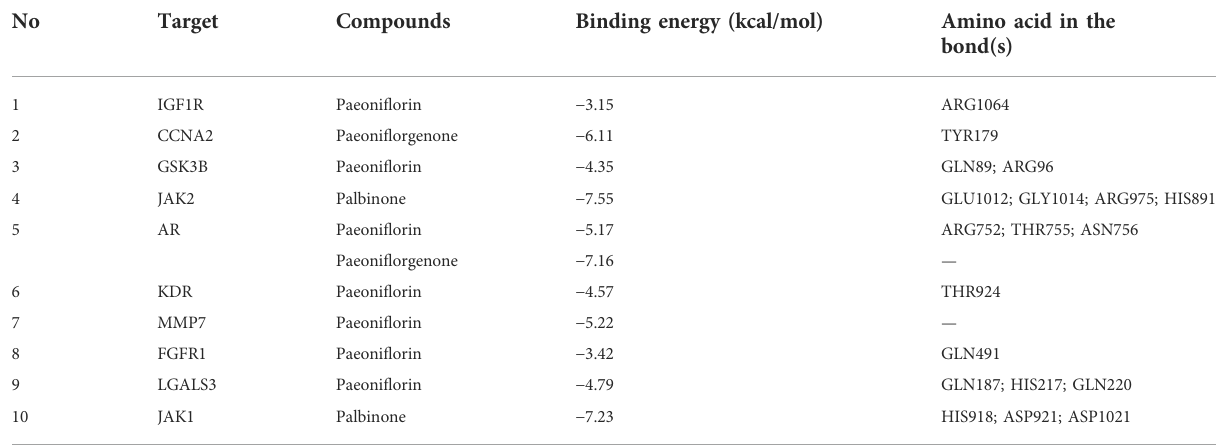
TABLE 1 The top 10 hub gene targets of Paeoniae Radix Alba in RA